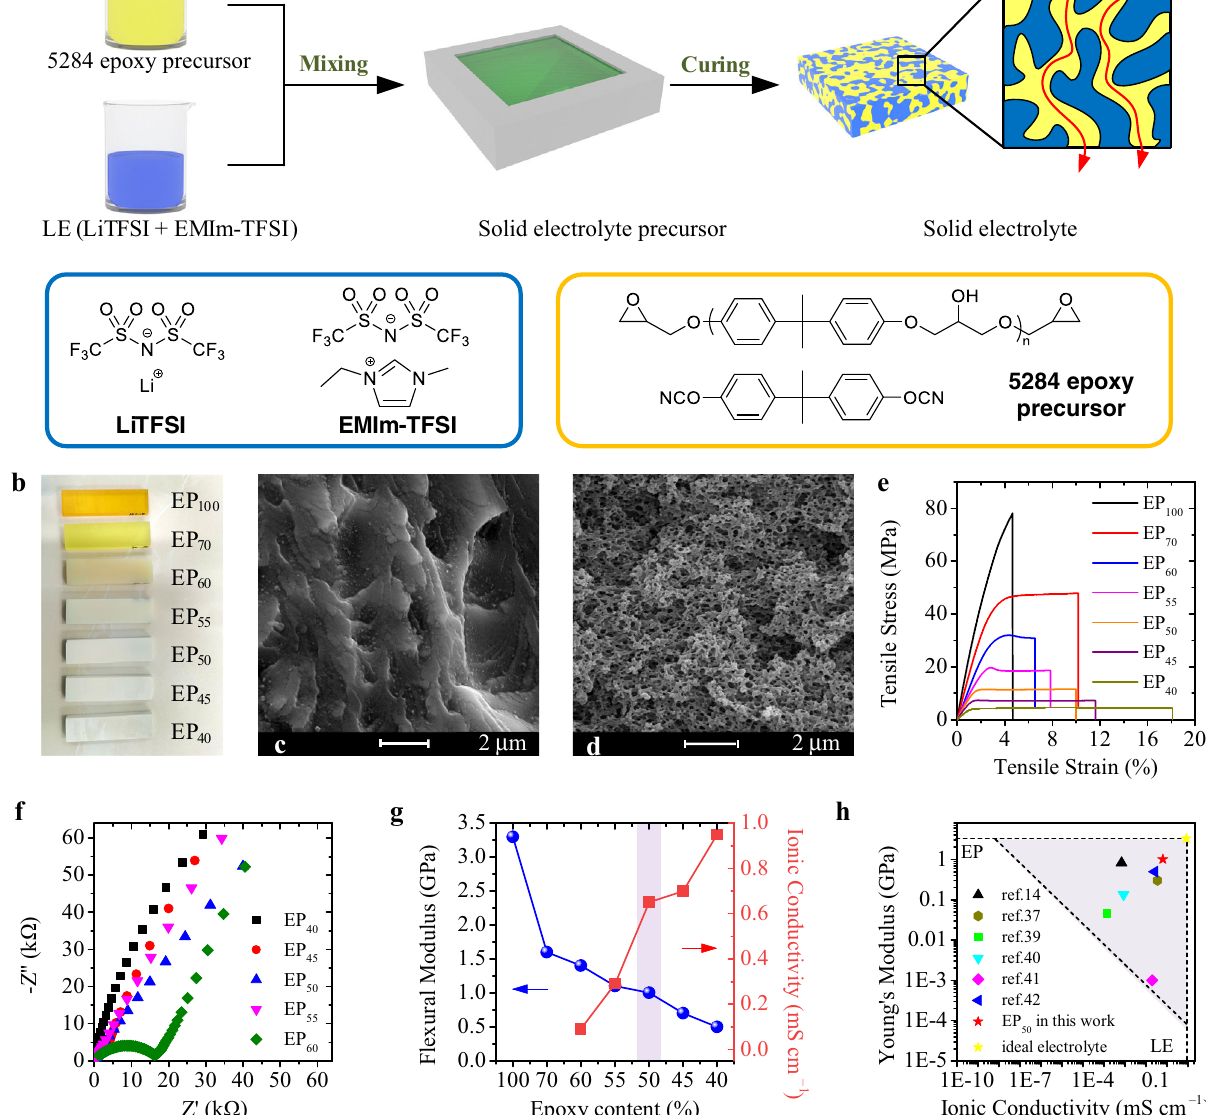
Fig. 1 | Structure and properties of the epoxy resin-based solid electrolyte. a Schematic diagram of the preparation of solid electrolyte with epoxy resin and ionic liquid, and the chemical structures of the epoxy resin and the ionic liquid. b Photosofepoxyresinwithdifferentionicliquidcontent. c , d SEMimagesof EP 70